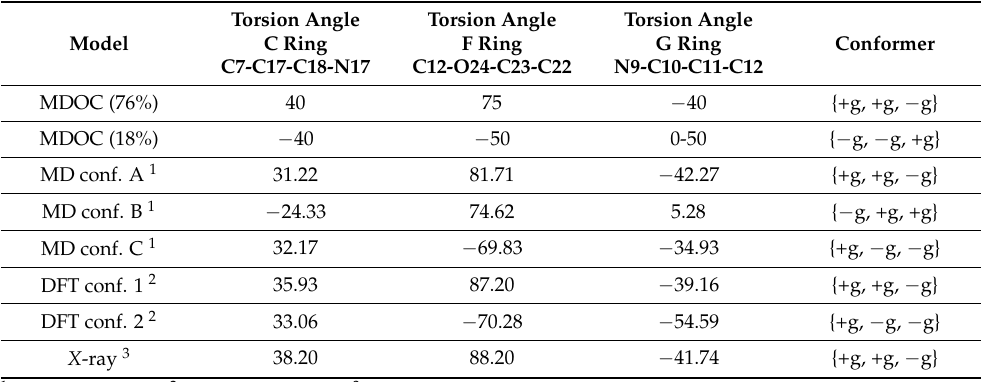
Table 4. Conformers of strychnine collected from the